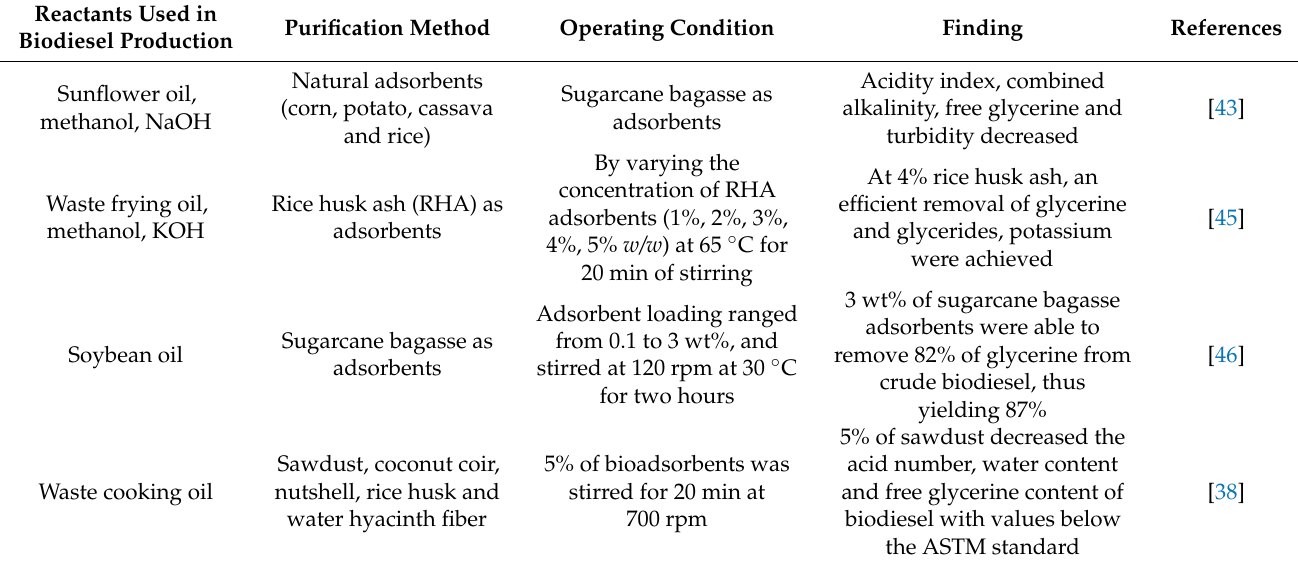
Table 2. Crude biodiesel refining using biomass-based